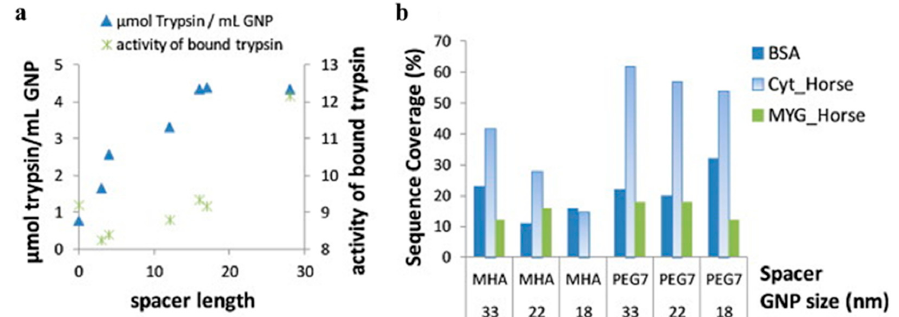
Figure 10. Influence of spacer length on immobilization chemistry and bioactivity. ( a ) With increase of immobilized enzymes (blue) an increase of the enzyme activity ( ∆ A 410nm min − 1 ) in the supernatant could be observed as well measured with N α -Benzoyl-DL-arginine 4-nitroanilide hydrochloride (BApNA) assay (green). ( b ) The right figure shows the sequence coverage (%) of the MASCOT search result for the digested proteins albumin, cytochrome C and myoglobin as a function of GNP size (33 nm, 22 nm and 18 nm according to dynamic light scattering—DLS, measurement) and of spacer length (MHA, mercaptohexadecanoic acid, spacer length: 17 atoms; PEG7, O-(2-carboxyethyl)-O’-(2-mercaptoethyl) heptaethylene glycol, spacer length: 28 atoms). Reproduced with permission from [60]. Copyright 2012, Elsevier B.V., Amsterdam,